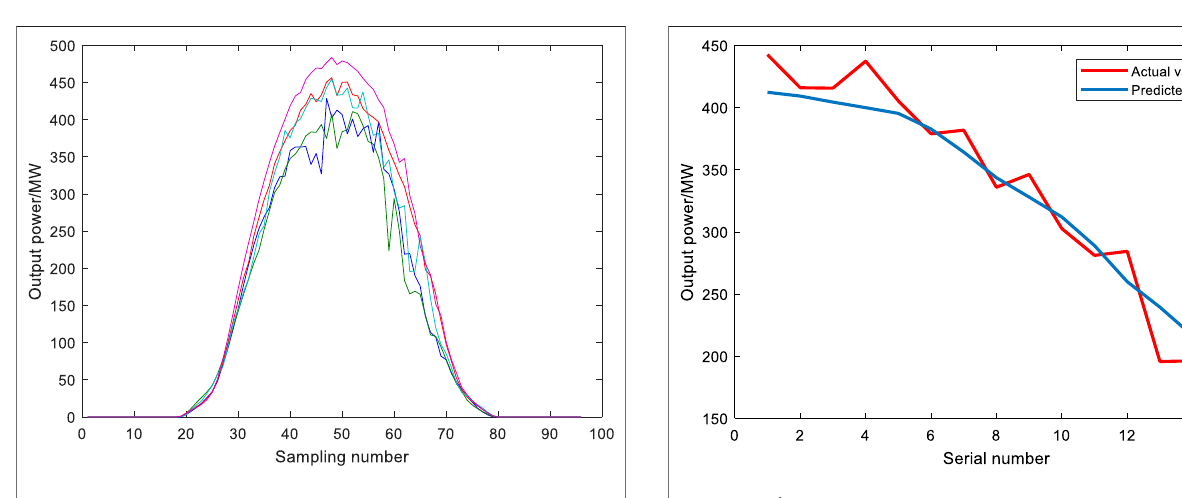
FIGURE 8 | Daily observed output power curves for the 5 days with the highest prediction accuracy.